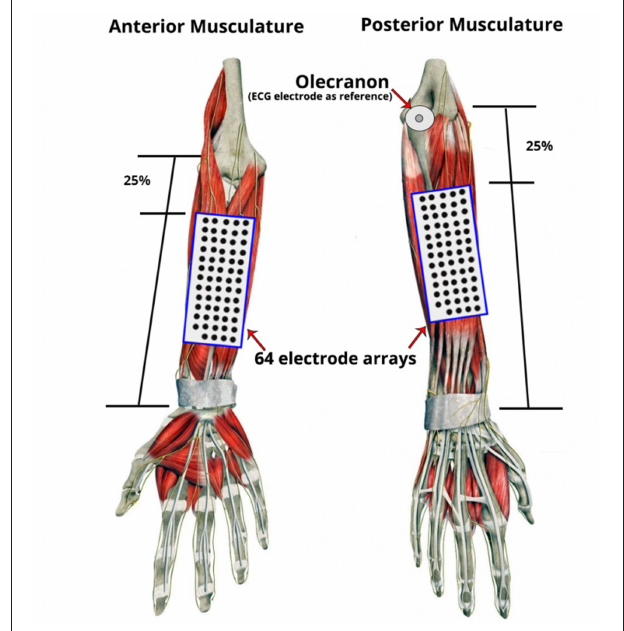
FIGURE 3 | Placement of electrode grids on the regions of interest (ROI): Anterior and Posterior Musculature. Two 13 by 5 electrode grids were placed over the skin of the forearm based on the anatomical landmarks of the forearm and relative to each participant’s forearm length and circumference dimensions. To standardize grid positioning across subjects, a simple proportional measurement based on distances between surface anatomical landmarks was employed. The distance between the ulnar head and the olecranon (for the posterior musculature) and the ulnar head to the elbow crease (for the anterior musculature) were measured and the respective grids aligned to a virtual line 25% from the proximal landmarks. An additional disposable ECG electrode was placed on the olecranon as the reference